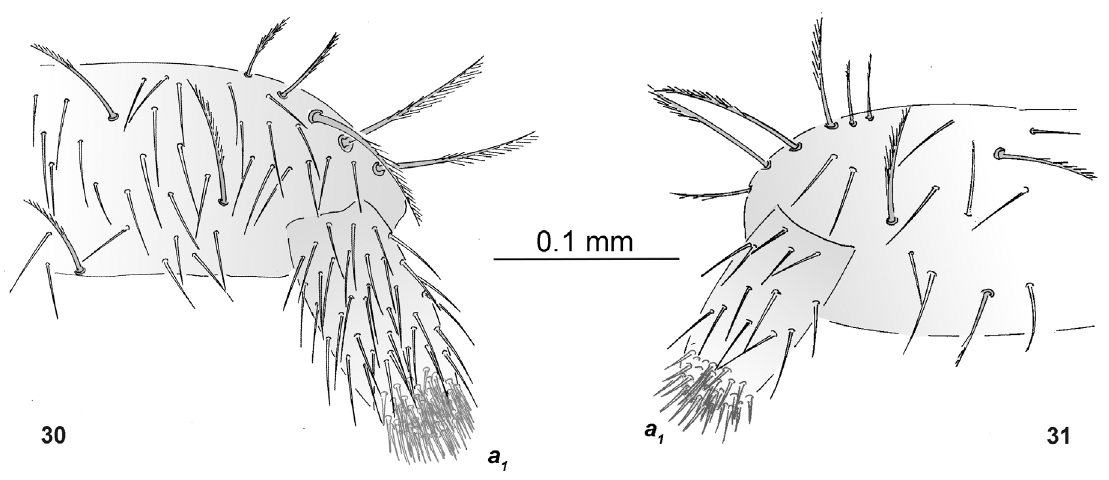
Figs 30–31. Turkmenocampa edaphica Sendra & Sánchez-García sp. nov., urosternite I, lateral side. 30 . ♂, paratype (MZB (MCNB) 2021-2341). 31 . ♀, holotype (MZB (MCNB) 2021-2340). Abbreviation: a = glandular setae in distal portion of 1